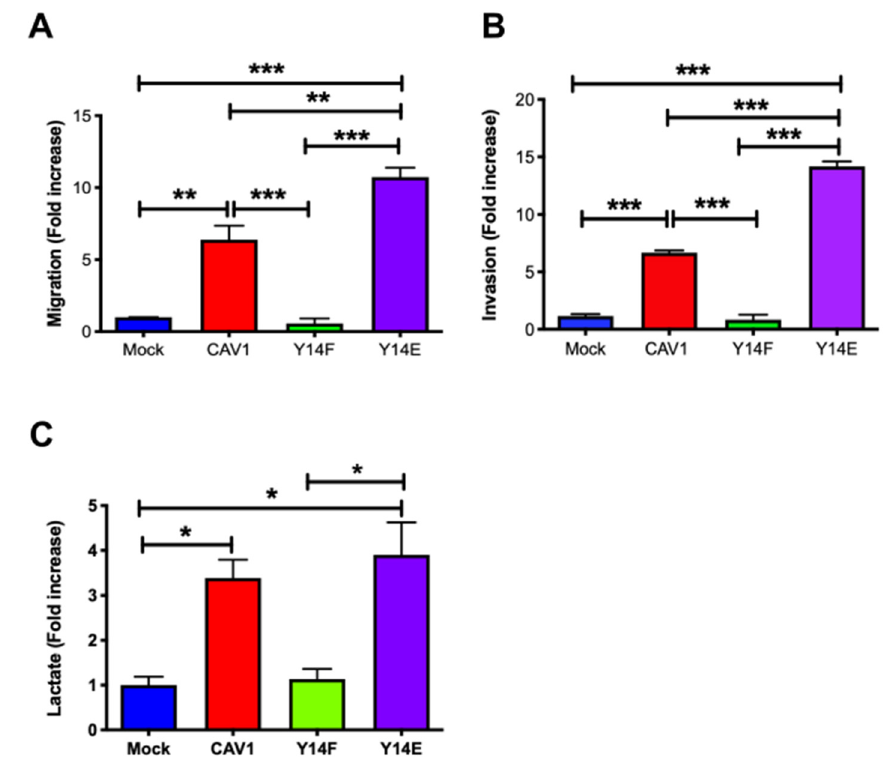
Figure 4. Phosphorylation on tyrosine 14 is necessary for maintenance of the metabolic phenotype induced by the expression of caveolin-1. Cells (2 × 10 5 ) B16F10(Mock), B16F10(CAV1), that express non-phosphorylatable CAV1 (B16F10(CAV1-Y14F)) and phosphomimetic CAV1 (B16F10(CAV1-Y14E)) ( A ) were seeded in Boyden chambers coated with fibronectin (2 µ g/mL) and allowed to migrate for 2 h. The cells that migrated through the pores were stained and counted. Values obtained were normalized to the control condition (Mock; on average 8 cells per field). ( B ) Cells were seeded in Matrigel-coated chambers and allowed to invade the matrix for 24 h. The cells that accumulated on the lower surface of the membrane were then stained, counted, and normalized to the control condition (Mock; on average 4.1 cells per field). The graphs show the average of results from three independent experiments (mean ± SEM). Significant differences are indicated *** p < 0.001, ** p < 0.01. ( C ) Cells (6 × 10 5 ) were seeded in 6 cm dishes, and 24 h later cells were treated for 48 h with 1 mM IPTG. Then media were collected, and lactate was determined using a L-Lactate Assay kit (Eton Bioscience Inc.) by measuring the absorbance at 490 nm. The graph shows the average of results from three independent experiments (mean ± SEM). The normalized value 1 is equivalent to 2 mM lactate. Significant differences are indicated, * p < 0.05.